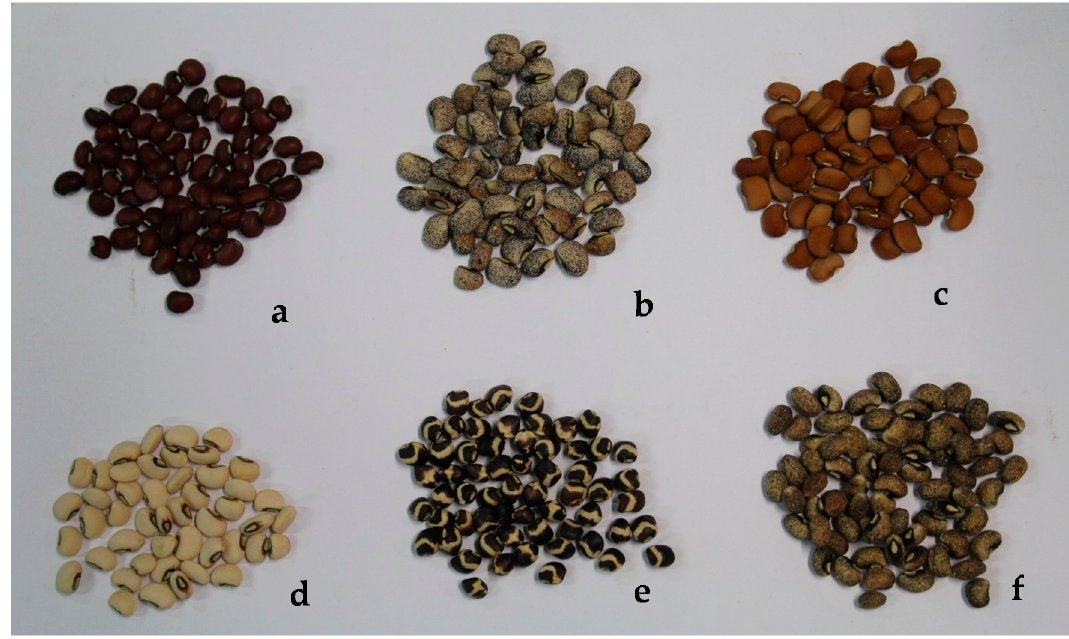
Figure 1. Seed colours of a few cowpea genotypes used. ( a ) CR06-07, ( b ) Local Labagela, ( c ) Gorom local, ( d ) Local Kondèsyoungo, ( e ) TVU 14676, ( f ) Mougne.